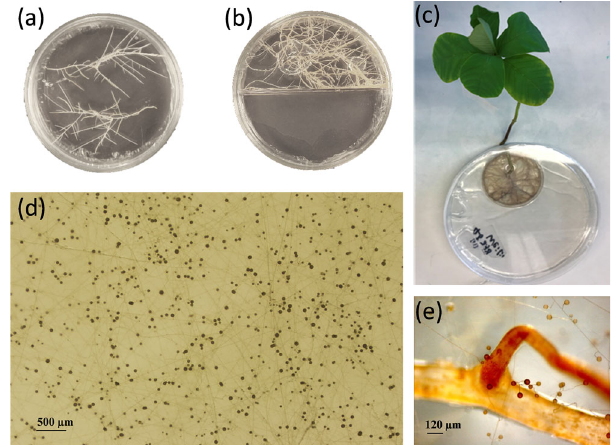
Fig. 4 In vitro cultivation of arbuscular mycorrhizal fungi. Cultivation system in ( a ) mono-compartmented or ( b ) bi-compartmented Petri dish on excised Ri T-DNA transformed root organs of carrot. c Cultivation with the whole plant of Crotalaria Spectabilis in a bi-compartment Petri dish system; d Mycelium and spore production of the AM fungus ( Rhizophagus irregularis , MUCL 41833) grown in a bi-compartmented Petri dish and ( e ) a mono-compartment Petri